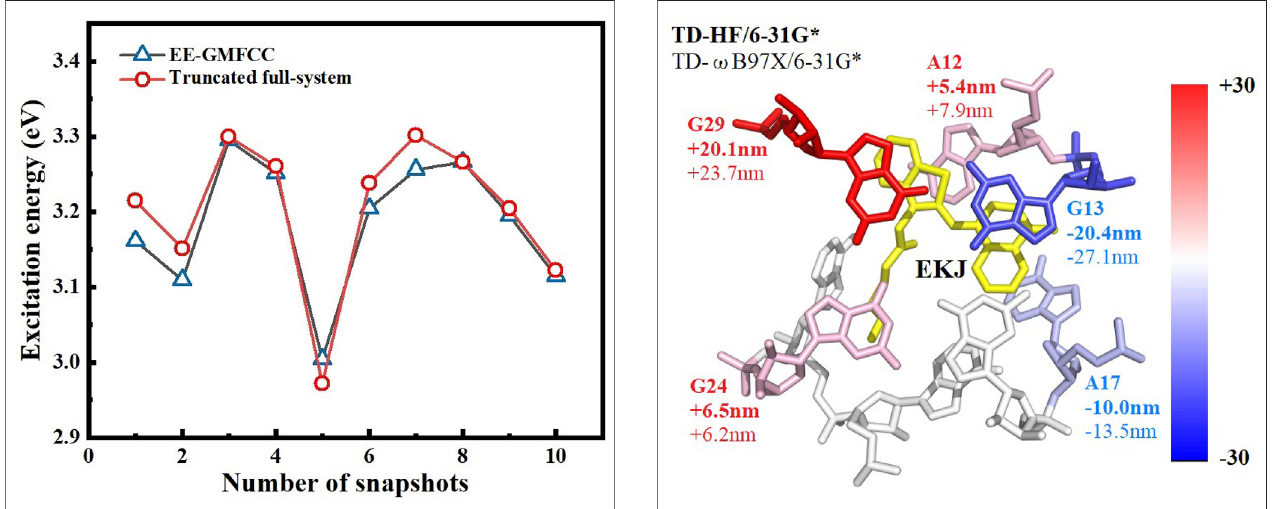
FIGURE 7 | Comparison of the calculated excitation energies for 10 different con fi gurations of the fl uorescent RNA – aptamer (PDB id: 6C63) system generated from the 100-ns MD simulation between the EE- GMFCC-2B approach and the truncated full-system calculations at the TD-HF/6-31G* level. λ 2B was set to 4 (cid:1) A for the two-body QM calculations in EE-GMFCC. λ FS was set to 4 (cid:1) Afor thetruncated full-system calculations.